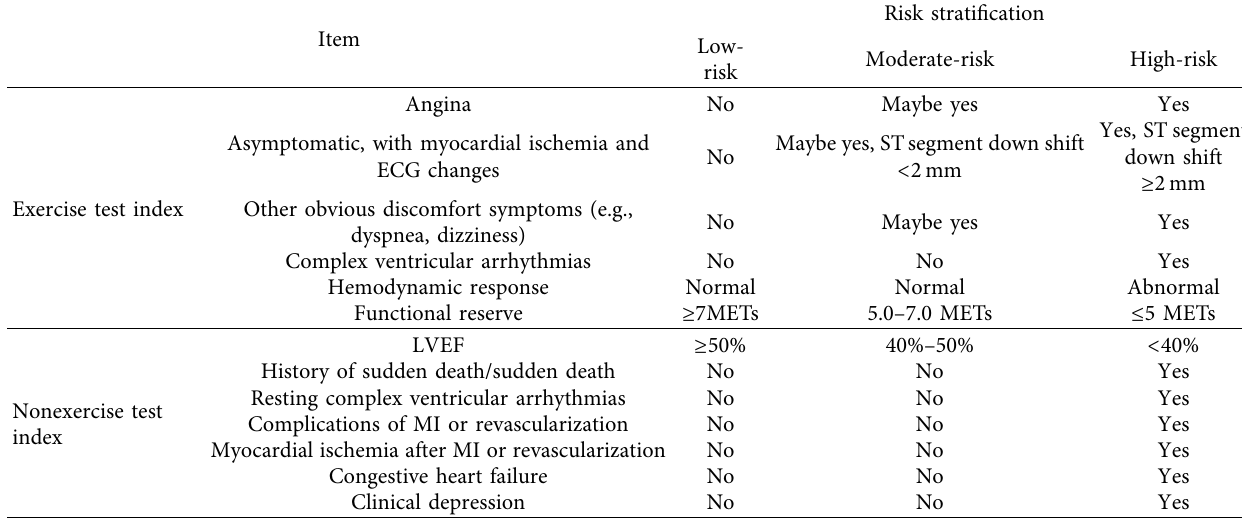
Table 1: Risk stratification of cardiovascular events during